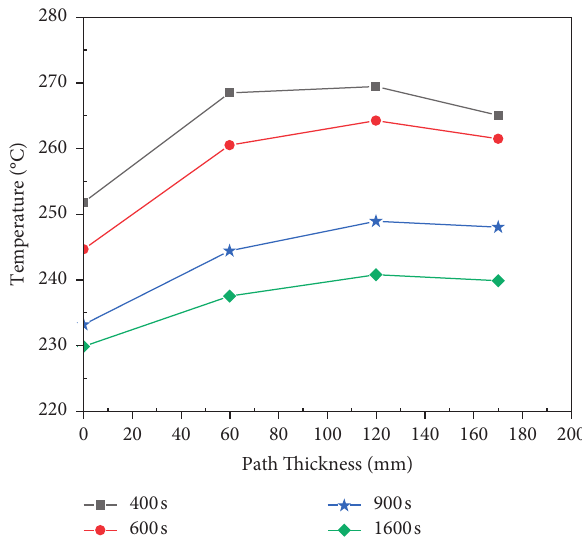
Figure 8: Temperature variation along the inlet nozzle-inside vessel wall intersection thickness of the FE model.